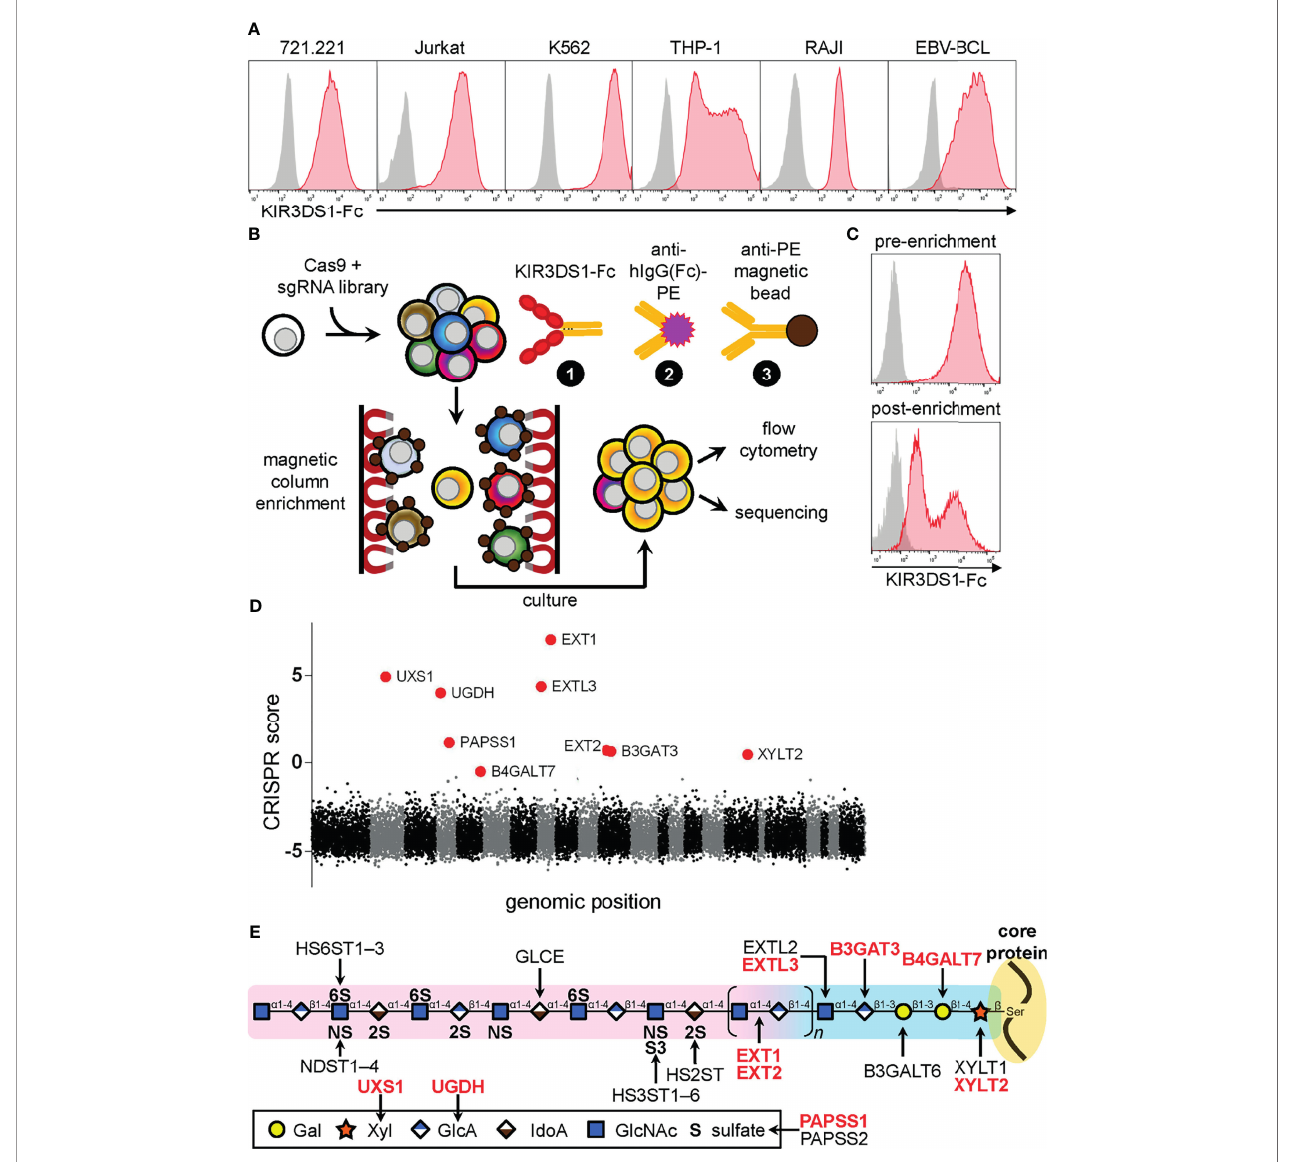
FIGURE 1 | Genome-wide CRISPR/Cas9-based screen for KIR3DS1 ligands identi fi es heparan sulfate biosynthesis pathway genes. (A) The indicated human cell lines were stained with KIR3DS1-Fc and anti-human IgG Fc secondary antibody (red histograms) or only with secondary antibody as a control (gray histograms). (B) Schematic illustration of the genome-wide CRISPR/Cas9-based screen and the strategy used to magnetically enrich for K562 library cells that lost expression of KIR3DS1 ligands. (C) Flow cytometry histograms of K562 library cells before ( top panel ) and after ( bottom panel ) magnetic enrichment are shown. (D) Dot plot depicting enrichment of sgRNA-targeted genes calculated from sequencing analysis of the enriched cell population. CRISPR score calculation is described in Material and Methods. Each dot indicates a particular gene, and each alternating section of black and gray dots indicates individual chromosomes (chromosomes 1 – 22 and X+Y). Large red dots indicate top nine enriched genes (hits), all of which were involved in heparan sulfate biosynthesis. (E) Diagram of heparan sulfate biosynthesis (structure and enzymes); the top nine hits are indicated in red bolded